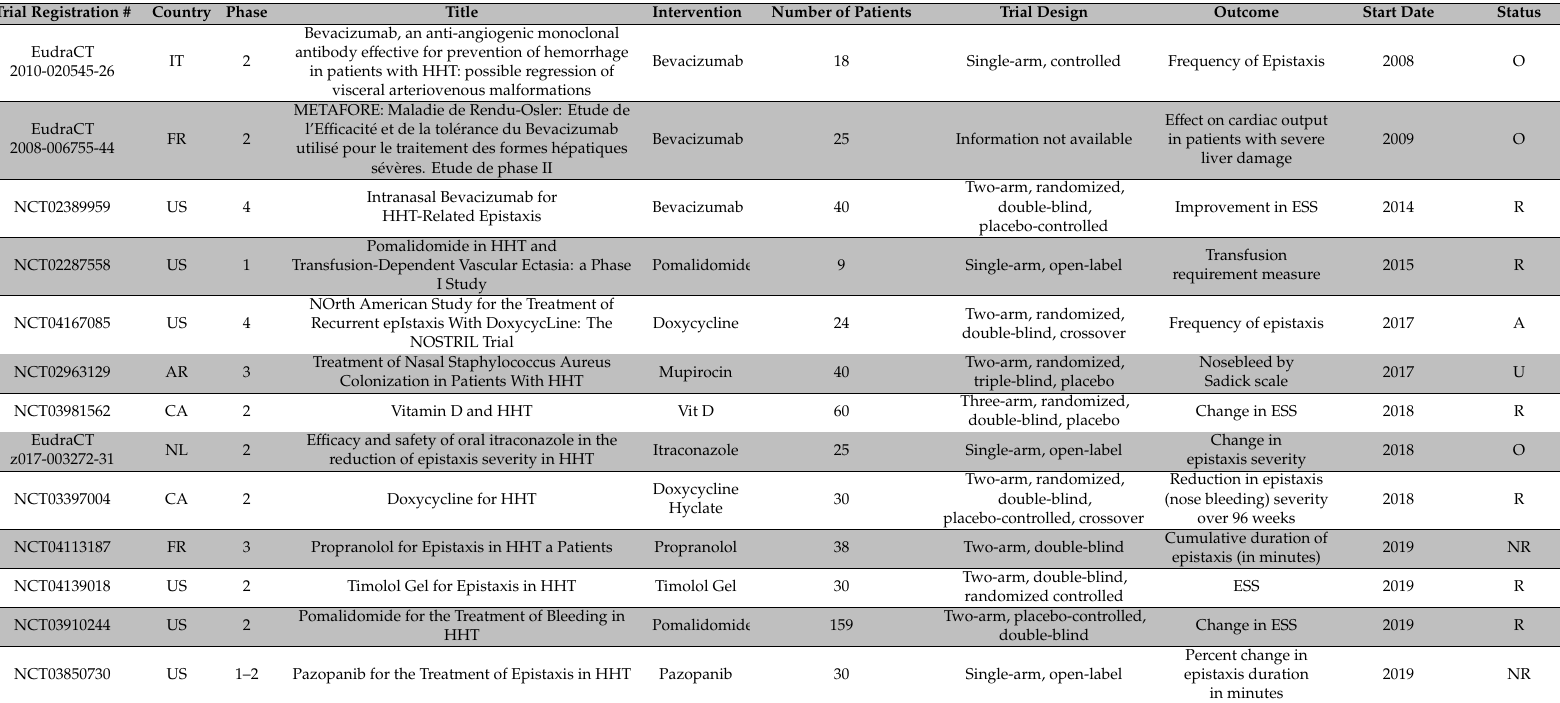
Table 2. Compilation of the HHT interventional clinical trials (Recruiting, Ongoing, or Unknown